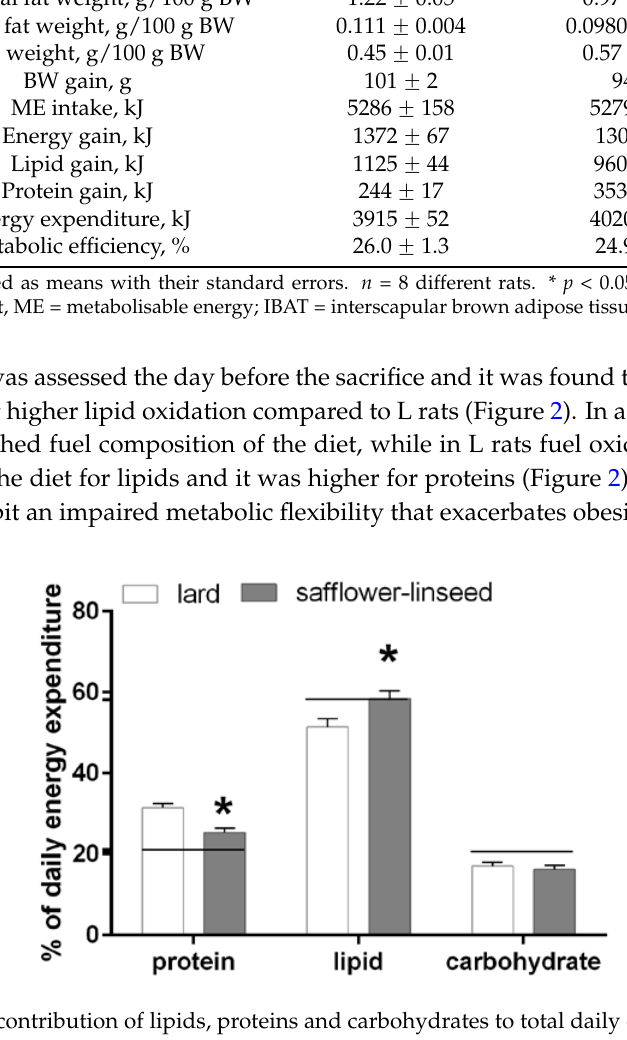
Table 3. Plasma parameters and liver composition in rats fed lard or safflower-linseed high fat diet.